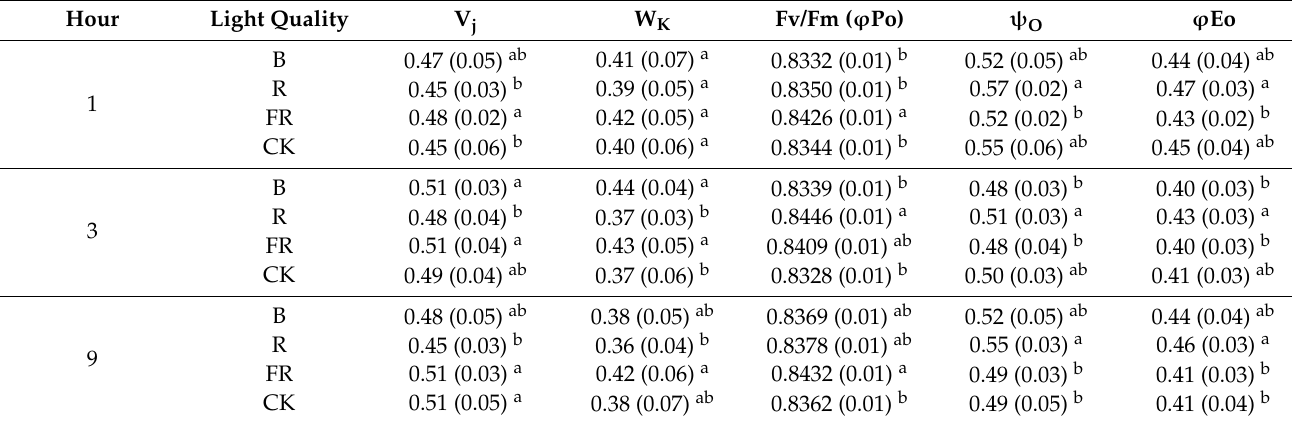
Table 4. Mean values (standard deviation) of Norway spruce chlorophyll a fluorescence parameters among four light treatment: blue (B), red (R), far-red (FR), and a combination of B, R and FR (CK).